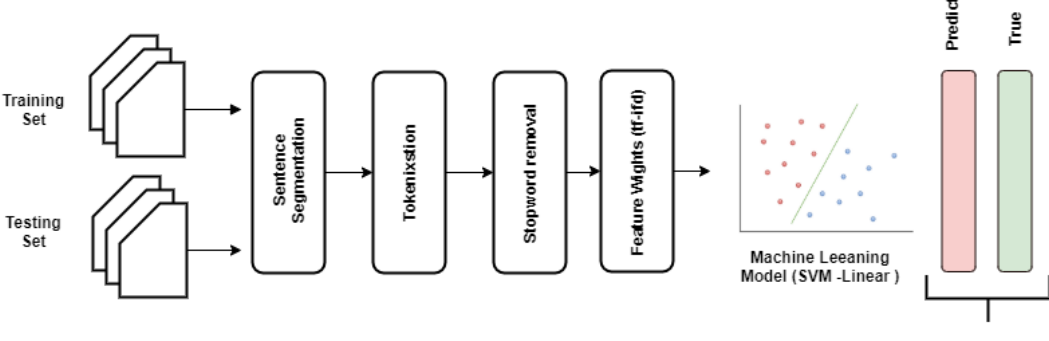
Figure 3. Pictorial representation of the traditional machine learning severity classification pipeline. SVM-Linear: Support vector machine learning with linear kernel, tf-idf : term frequency—inverse document frequency. Blue and red dots indicates